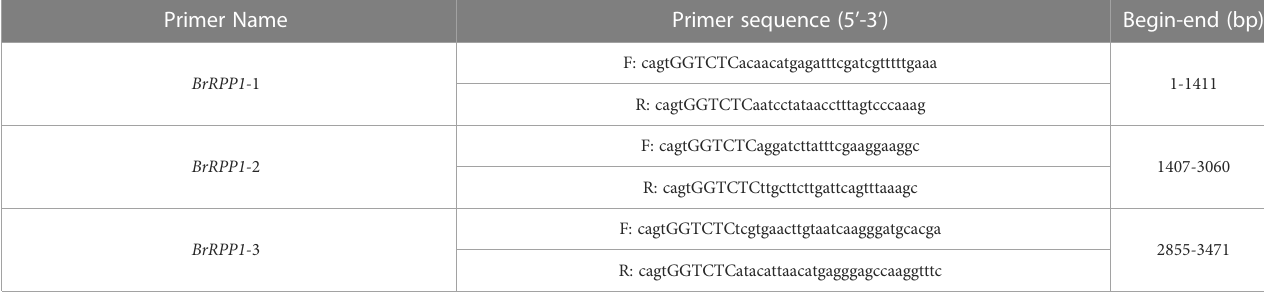
TABLE 1 The Primers for amplifying the full cDNA sequence of